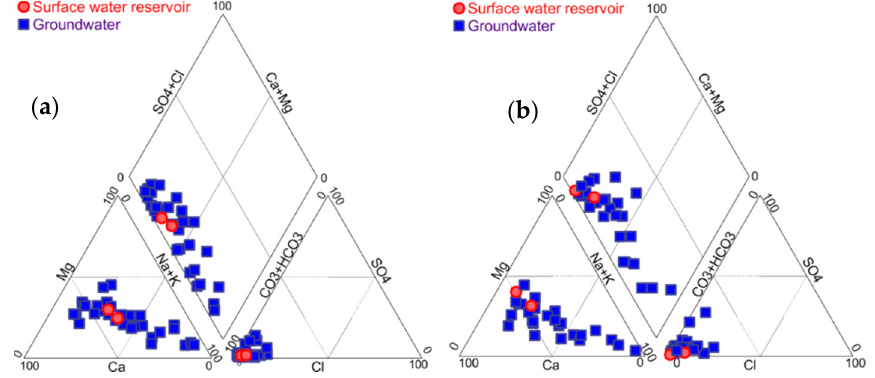
Figure 10. Chemical composition of SWR in the dry ( a ) and rainy ( b ) seasons within Mogtédo watershed.